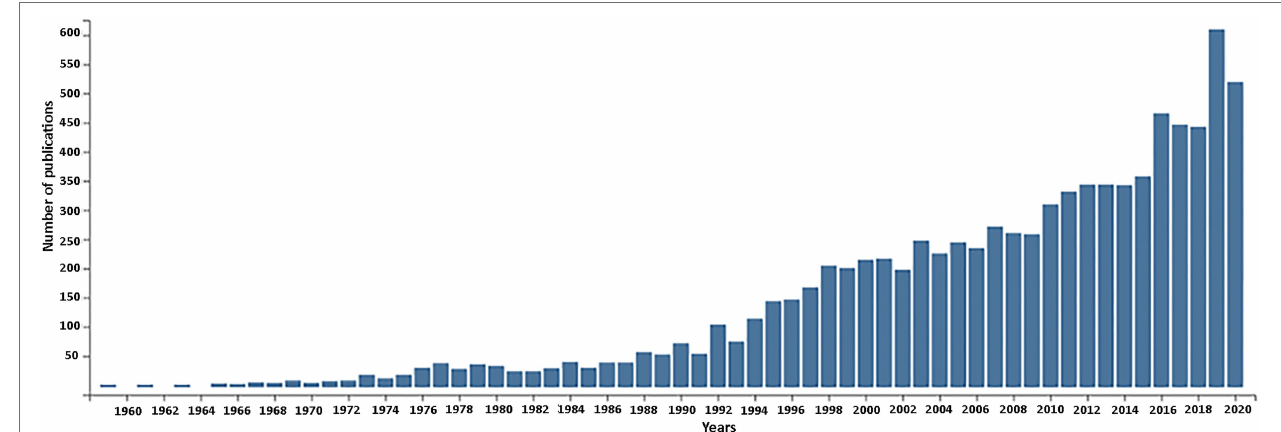
FIGURE 1 | Publications related to plant nuclear rDNA research over the timespan of 1960–2020. The number of retrieved publications is shown in 2-year increments. The total number of publications returned by the Web of Science database was 8,948. Key words used for searched fields: rRNA or rDNA and